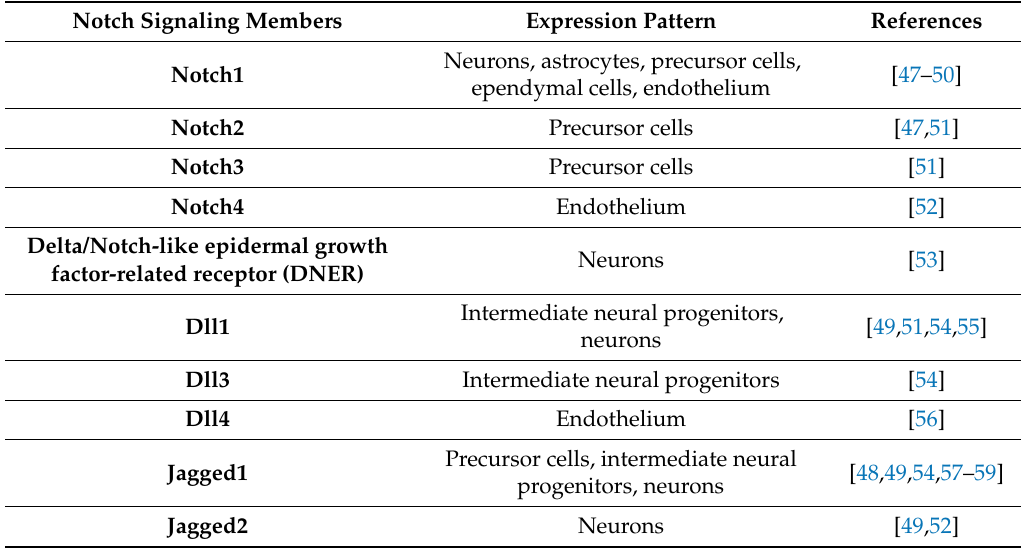
Table 1. Expression pattern of Notch receptors and ligands in the adult